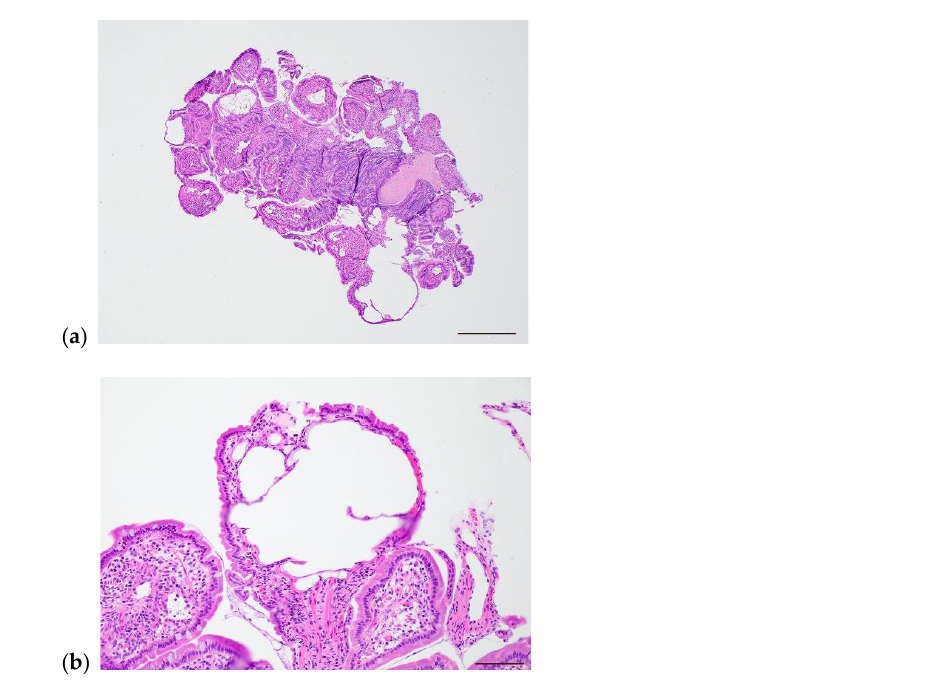
Figure 2. Photomicrographs of intestinal lymphangiectasia in a 5-year-old female, spayed soft-coated wheaten terrier. ( a ) Low-power image showing numerous moderate to markedly dilated lymphatics. Scale bar = 500 µm. ( b ) High-power image of markedly dilated villus lacteal. Scale bar = 100 µm.